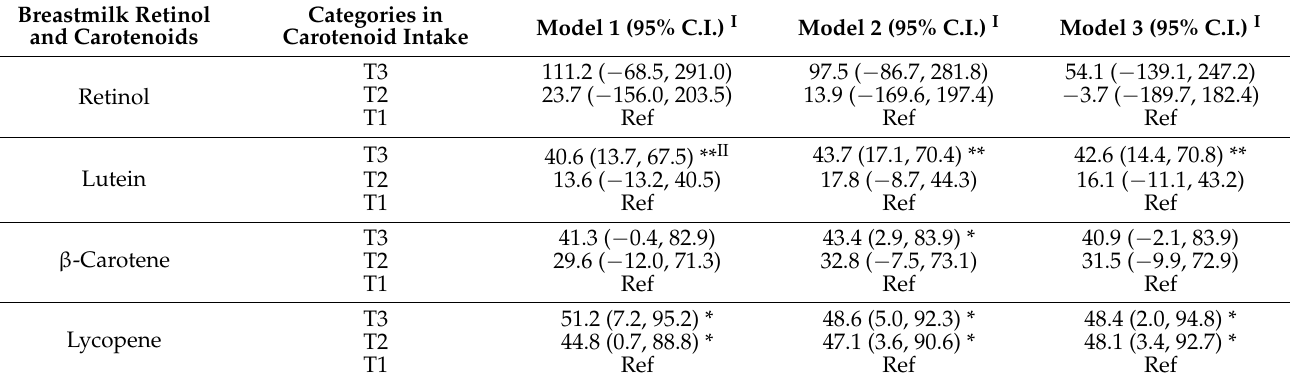
Table 4. Regression coefficients on the association between carotenoid intake and the levels of breastmilk retinol and carotenoids after excluding supplemental carotenoid intake. Breastmilk Retinol and